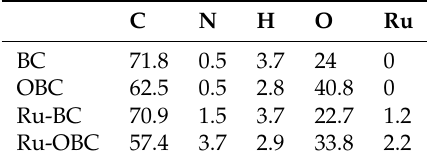
Table 3. Elemental Analysis (Mass